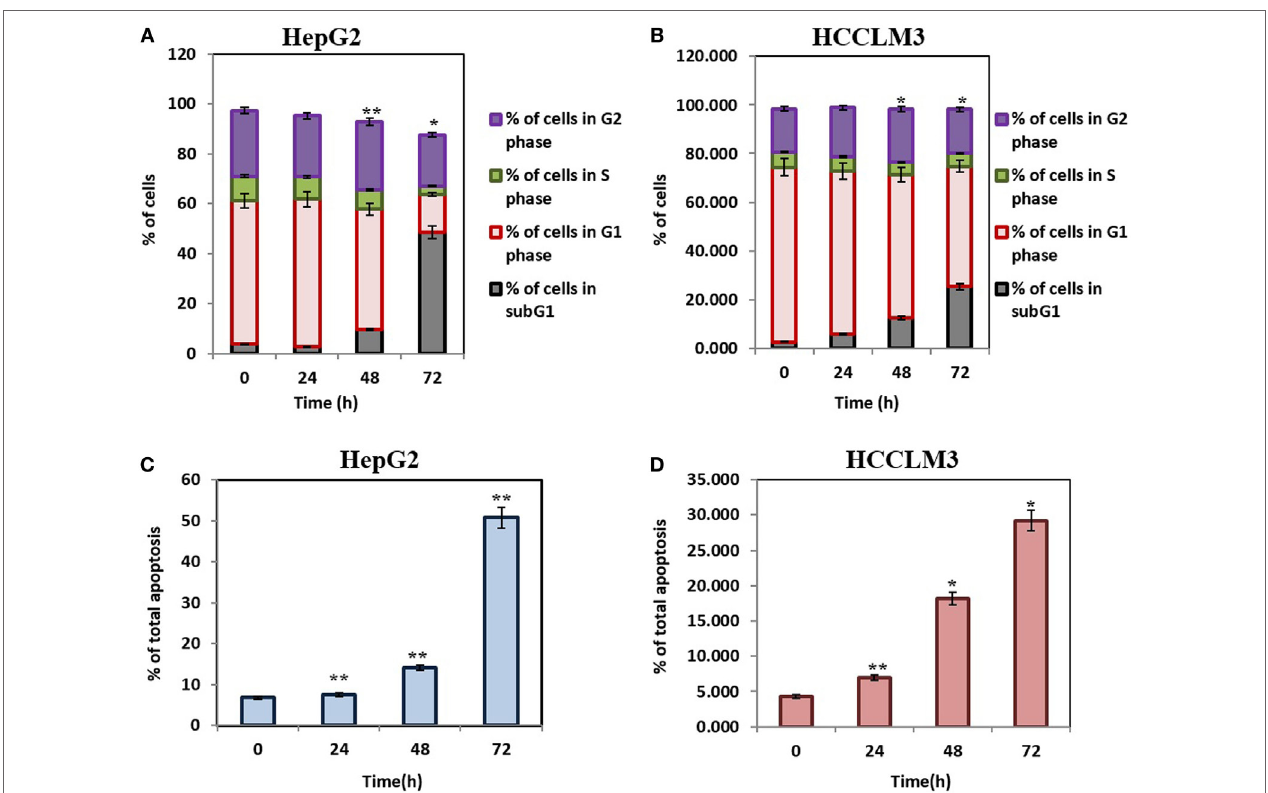
FigUre 2 | (a,B) CMO induces accumulation of hepatocellular carcinoma (HCC) cells in SubG1 phase. HepG2 and HCCLM3 cells were treated with 50 µM of CMO for 24, 48, and 72 h, after which, the cells were washed, fixed, stained with propidium iodide, and subjected to flow cytometric analysis. (c,D) CMO induces substantial apoptosis in HCC cells. HepG2 and HCCLM3 cells were exposed to 50 µM CMO at indicated times, after which, cells were harvested and stained with Annexin V and propidium iodide. The percentage of early and late apoptosis in the HCC cells treated with 50 µM CMO was examined using flow cytometry. The bar graph shows total percentage of apoptotic cells of HepG2 and HCCLM3 upon treatment with 50 µM of CMO at the indicated time points. The data are expressed as mean ± SD, compared with the untreated control (* p < 0.05, ** p <